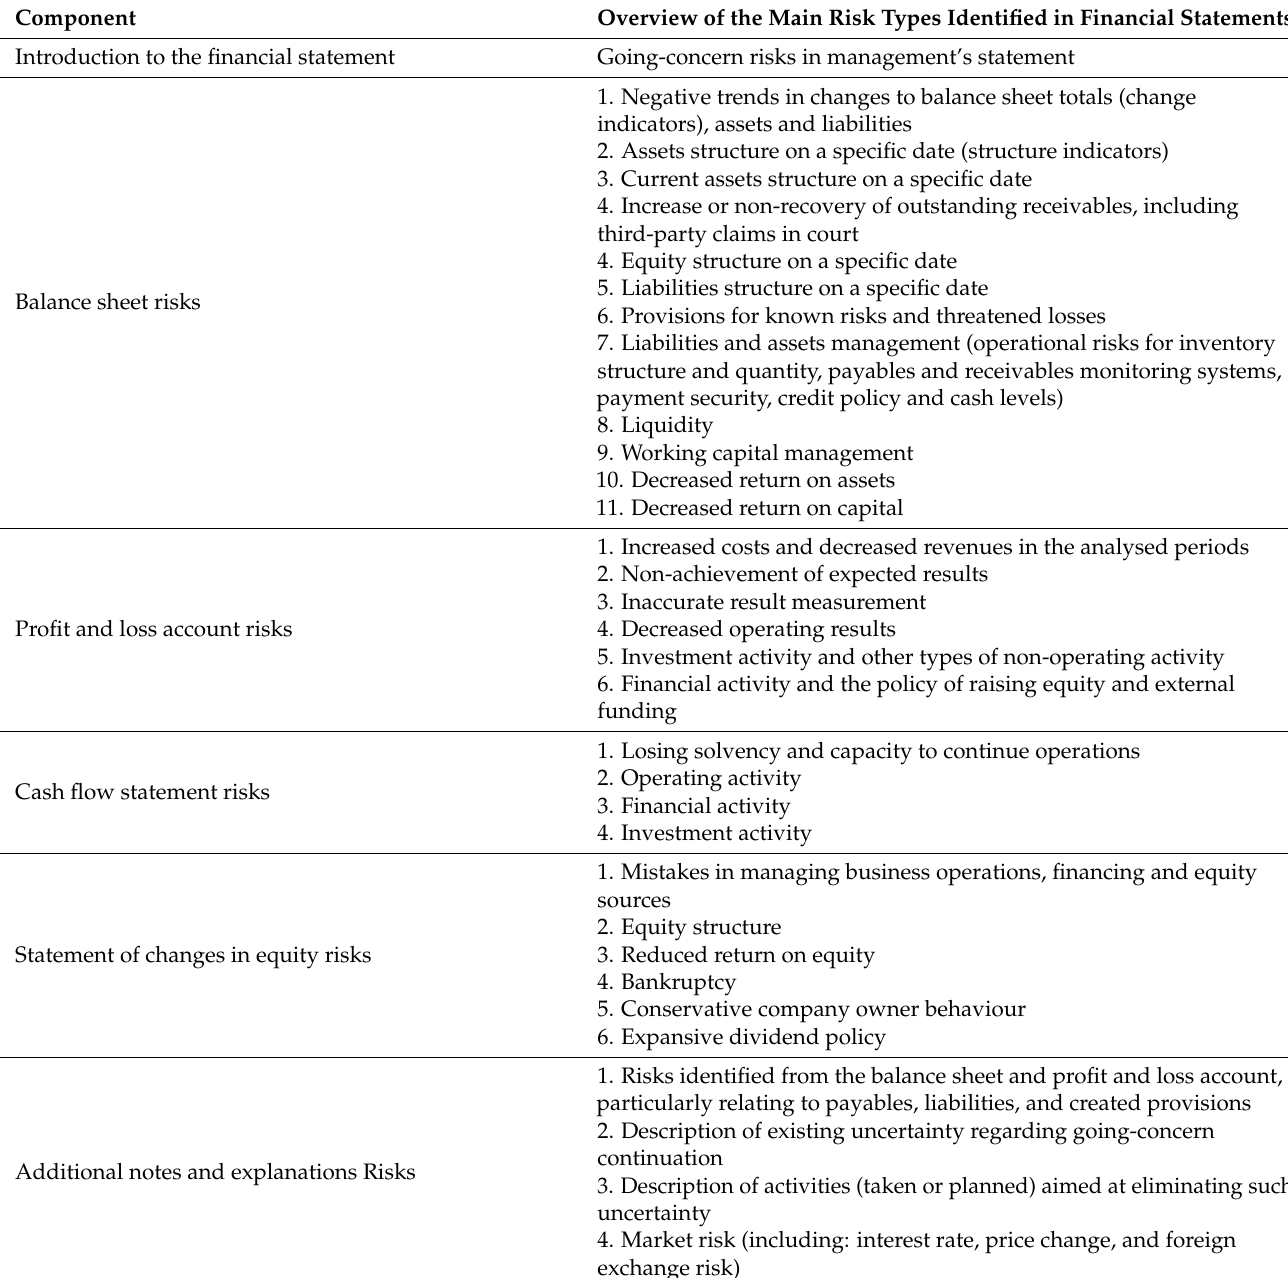
Table 1. Identification of business activity risks in annual financial